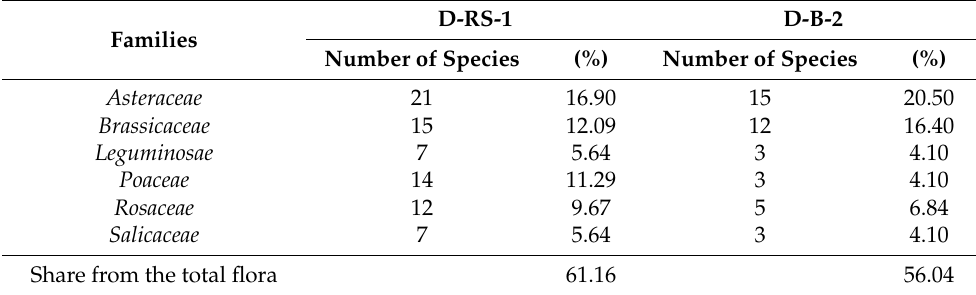
Table 2. The number and percentage share of the species in the selected